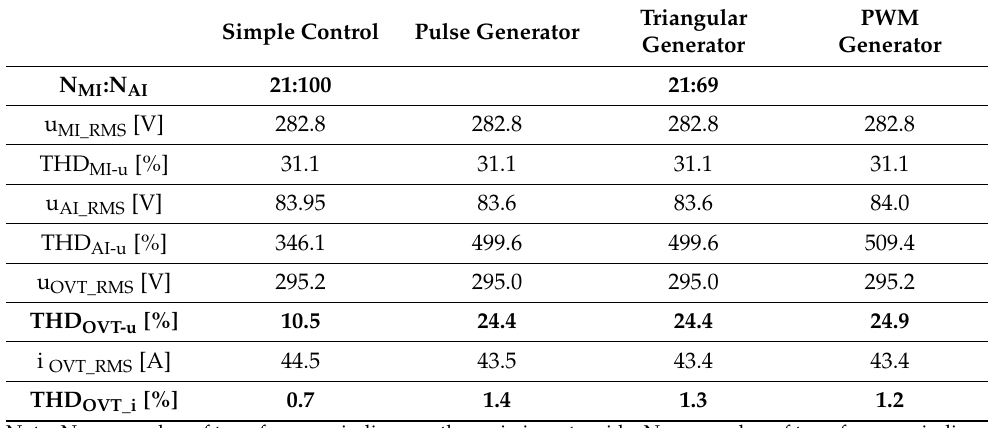
Table 3. Comparison of the RMS and THD parameters for the voltages and currents of the OVT, MI, and AI inverters with different control strategies of the AI inverter.